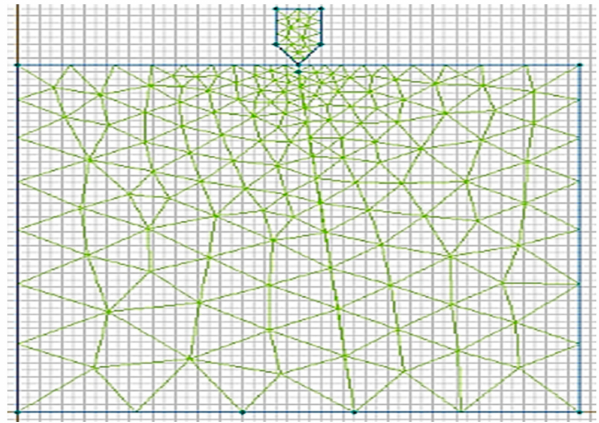
Figure 11. Meshing and